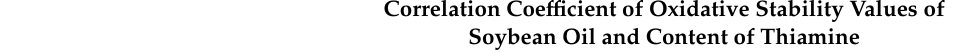
Table 1. Correlation coe ffi cients between oxidative stability values of soybean oil and content of thiamine hydrochloride in presence of ethanol tea